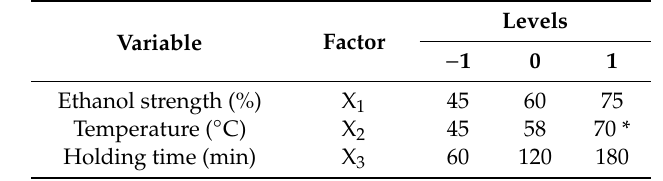
Table 5. Coding and levels of variables considered in optimizing extraction yield of phenolic